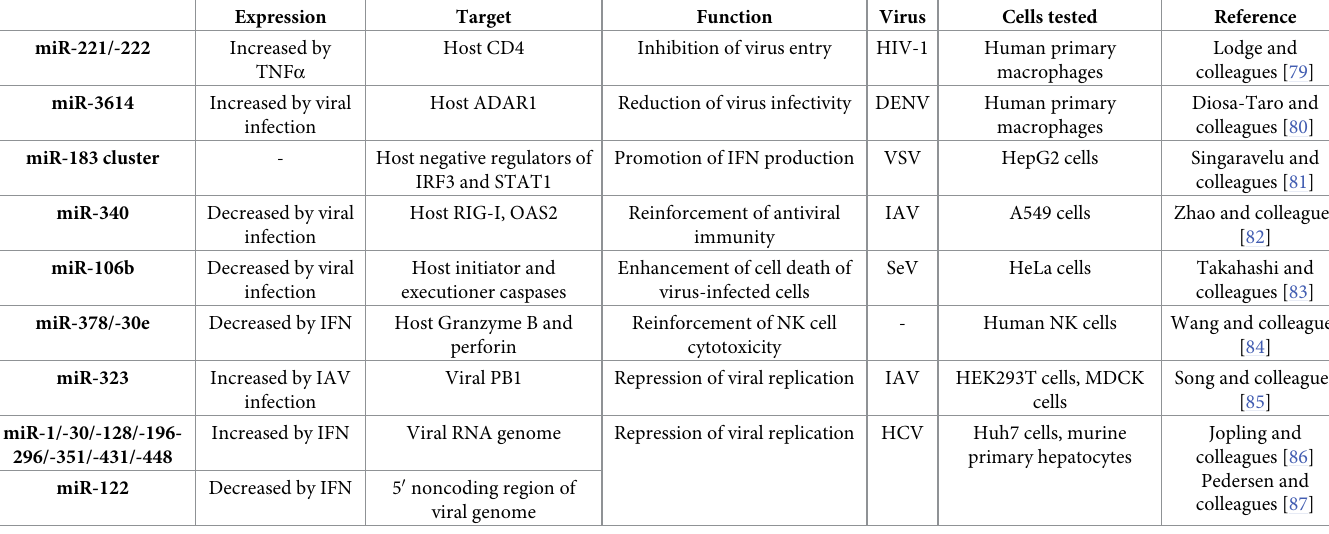
Table 3. Examples of antiviral immunity directed by endogenous